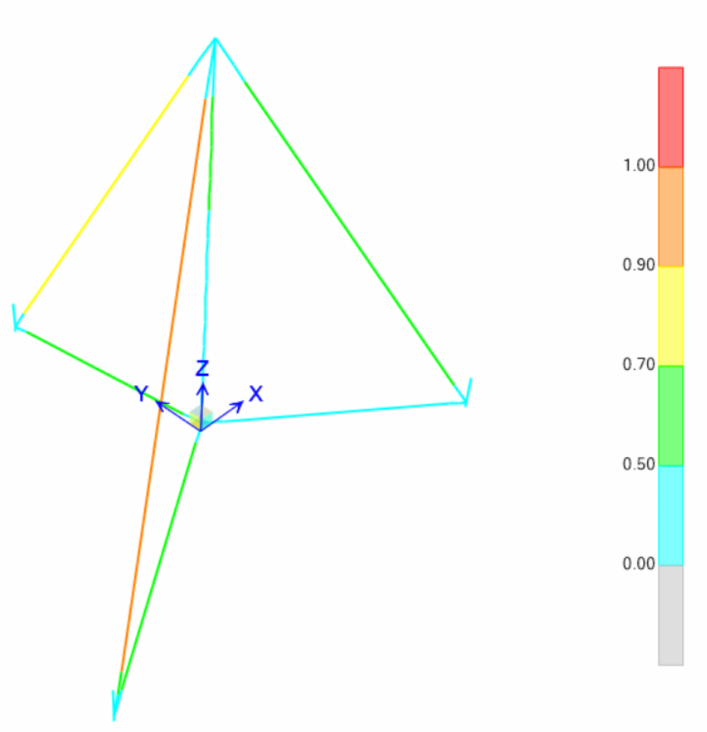
Figure 16. Utilization ratios of the steel superstructure considering all the loading